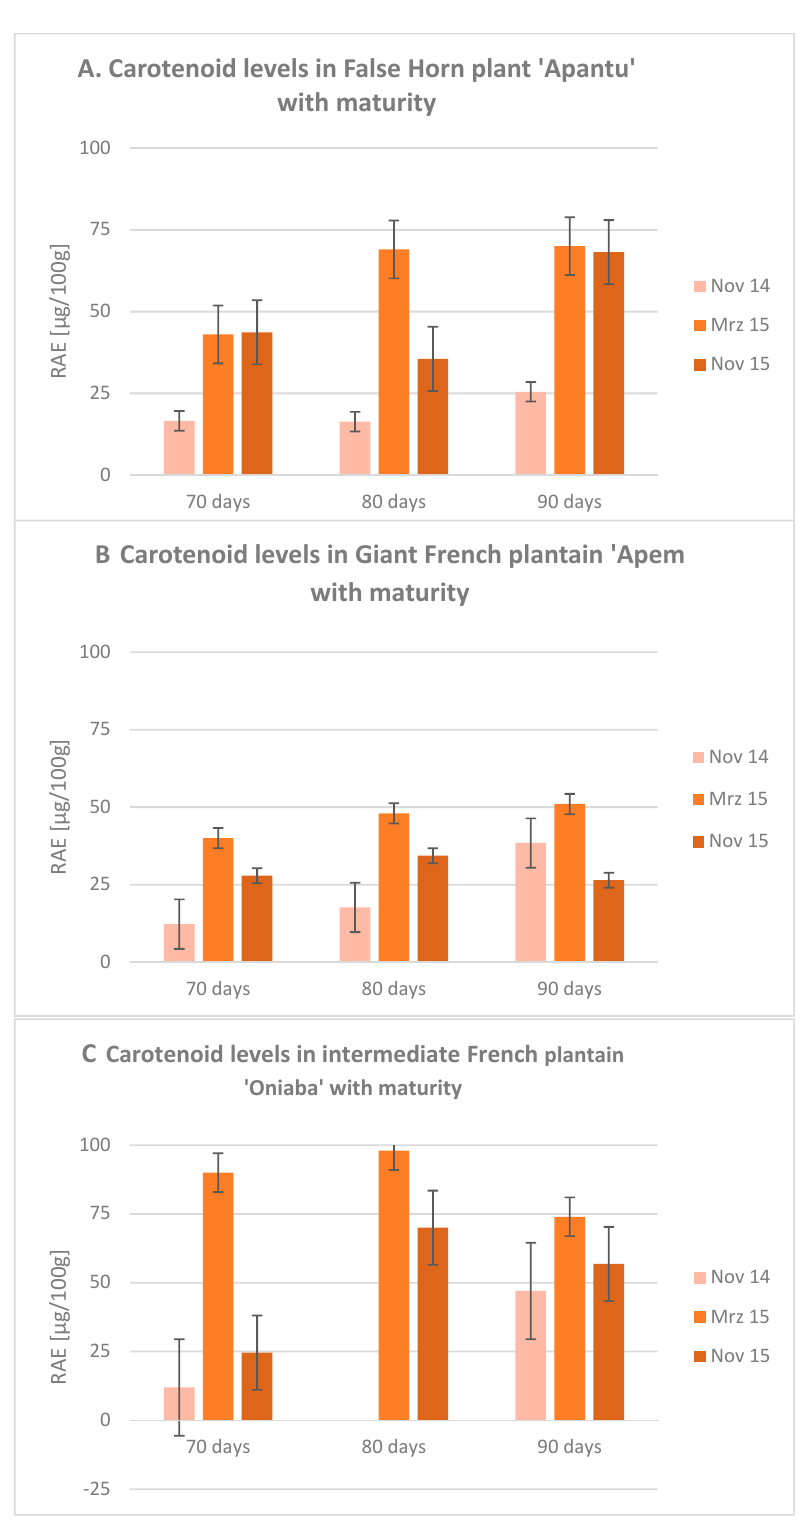
Figure 1. Maturation and season dependent changes in Retinol Activity Equivalents (conversion factors: 1:12 for β -carotene, 1:24 for other provitamin A active carotenoids) in three di ff erent plantain cultivars, ( A ) “Apantu”, ( B ) “Apem” and ( C ) “Oniaba”. Plantain samples were harvested after 70, 80 and 90 days after flowering in dry and rainy seasons.